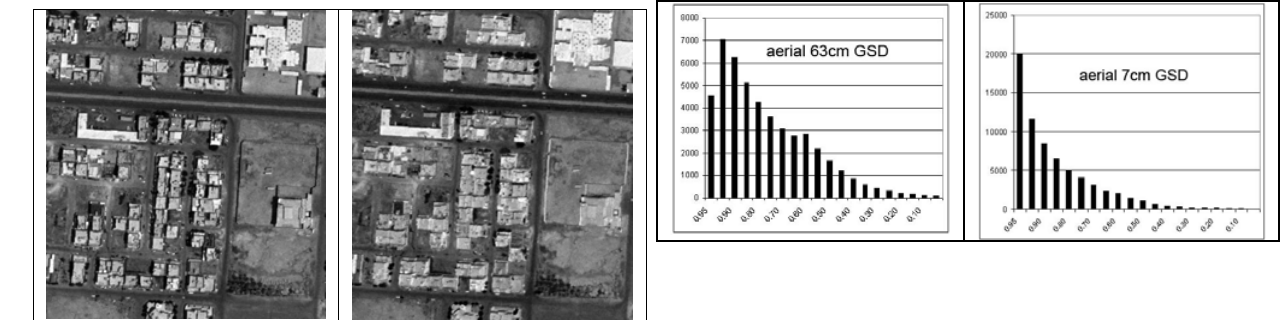
Figure 4: part of corresponding aerial images 63cm GSD